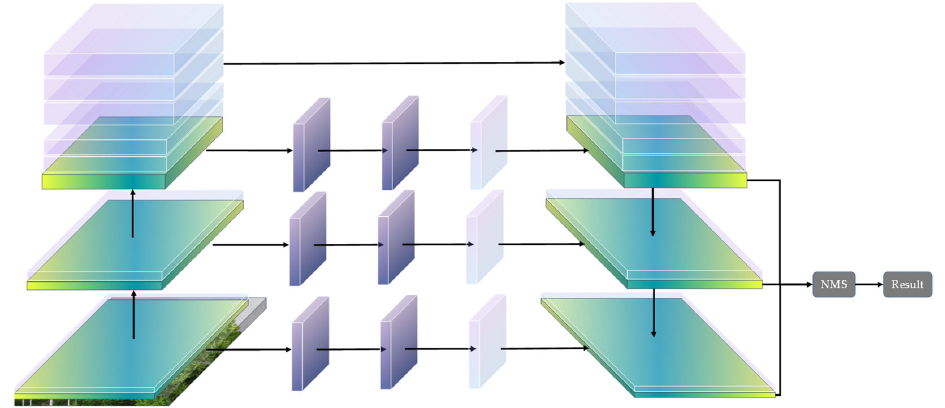
Figure 1. Proposed net